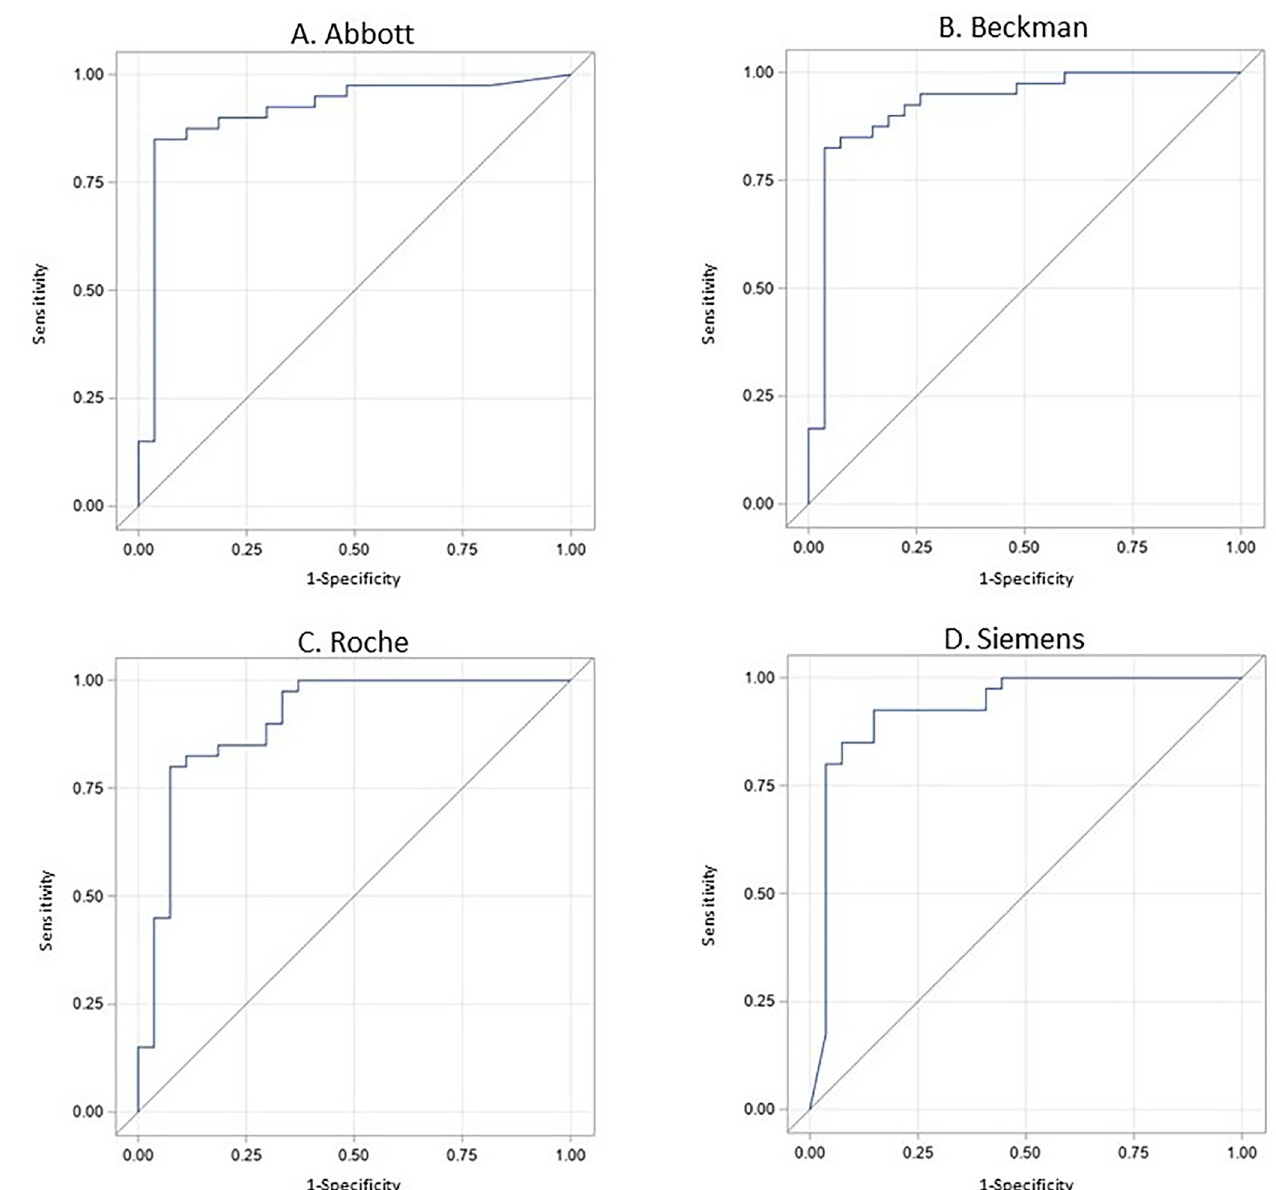
Fig 2. ROC curves for each antibody binding assay according to Genscript